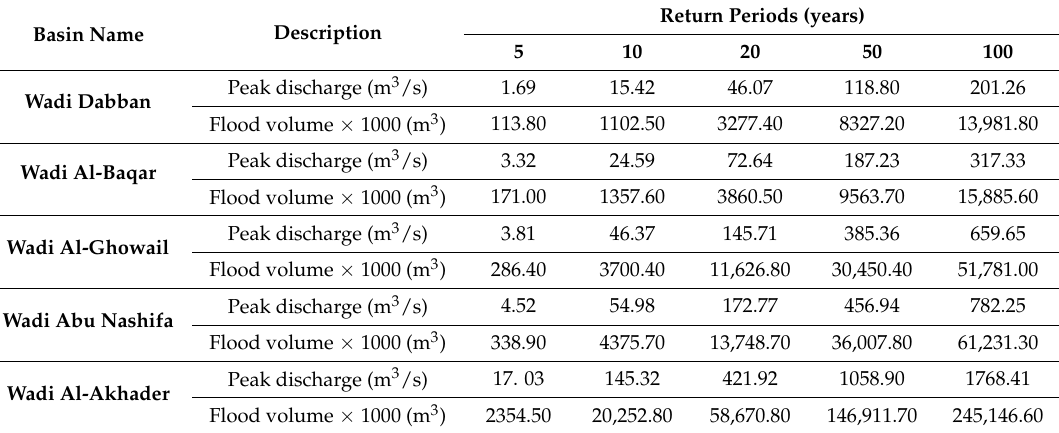
Figure 6. Combination map of soil type and land use units used to calculate curve number of drainage basins. Table 4. Characteristics of floods in main drainage basins for different return